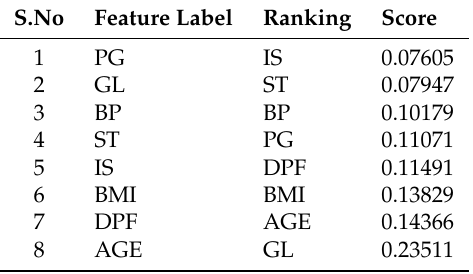
Table 3. Feature ranking and importance by decision tree (DT) (ID3) algorithm.